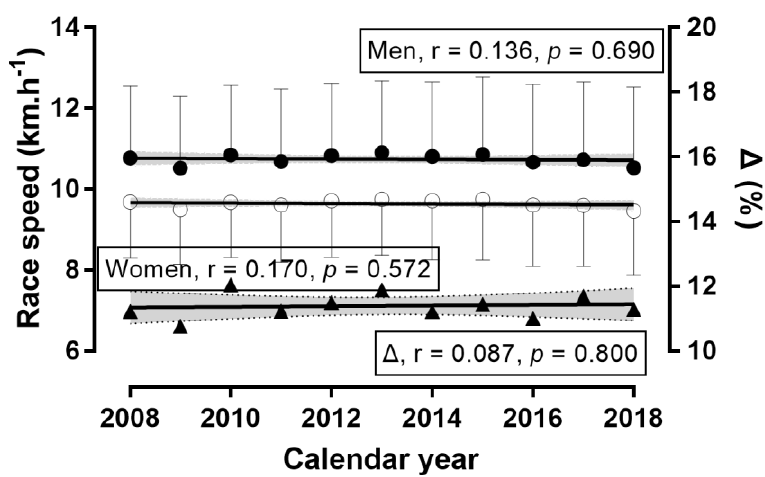
Figure 2. Running speed of finishers by calendar year. Note: Δ = sex difference; error bars denote standard deviation; shadowed areas denote 95% confidence intervals; = women, ⚫ = men.